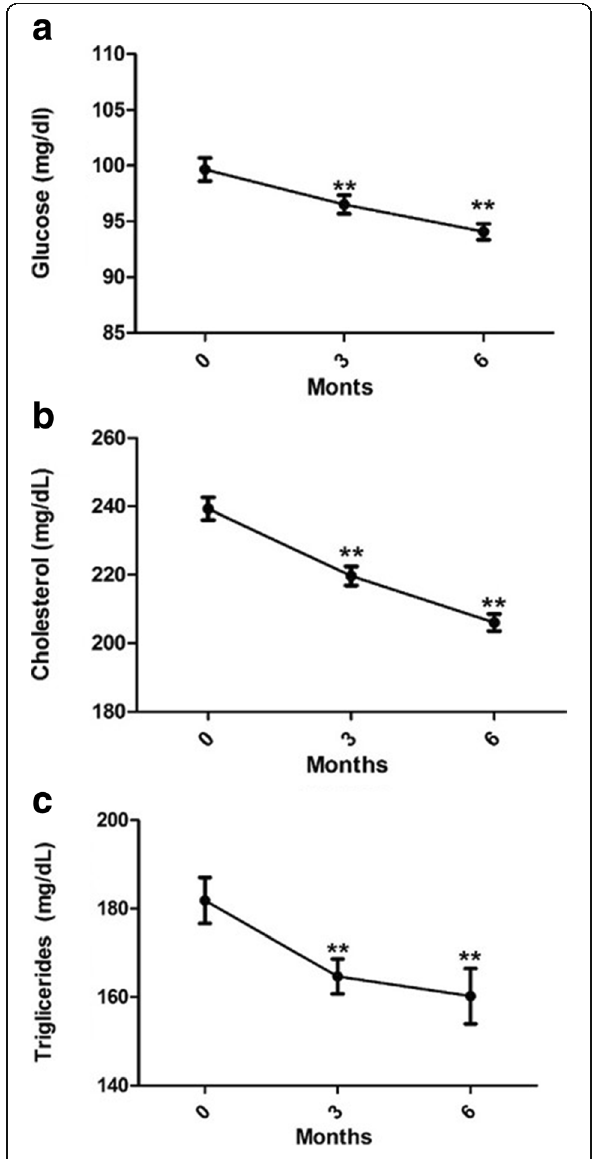
Fig. 2 Effect of GC and GNN on level of metabolic markers. Glucose ( a ), Cholesterol ( b ) and Triglycerides ( c ). ** p < 0.01 vs treatment onset (0